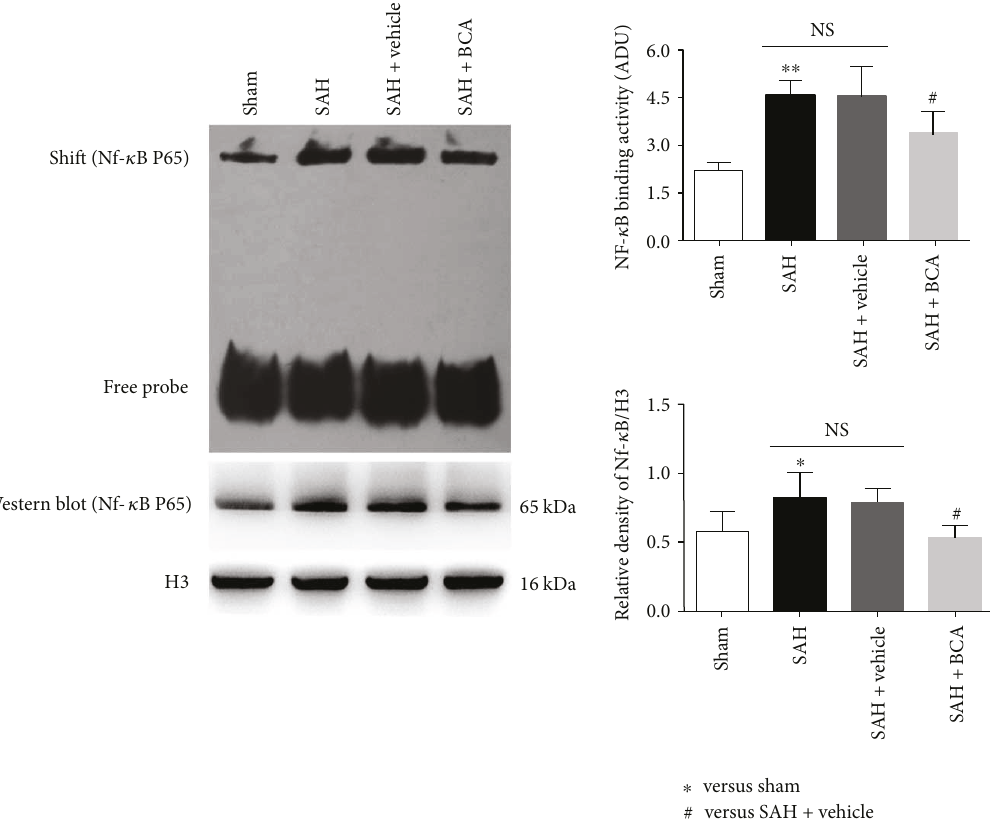
Figure 6: BCA administration suppressed NF- κ B/DNA-combining activation and the nuclear level of NF- κ B p65 at 24 hours post SAH ( n = 6 , each group; ∗ P < 0 05 versus sham; ∗∗ P < 0 01 versus sham; # P < 0 05 versus SAH +vehicle; NS P > 0 05